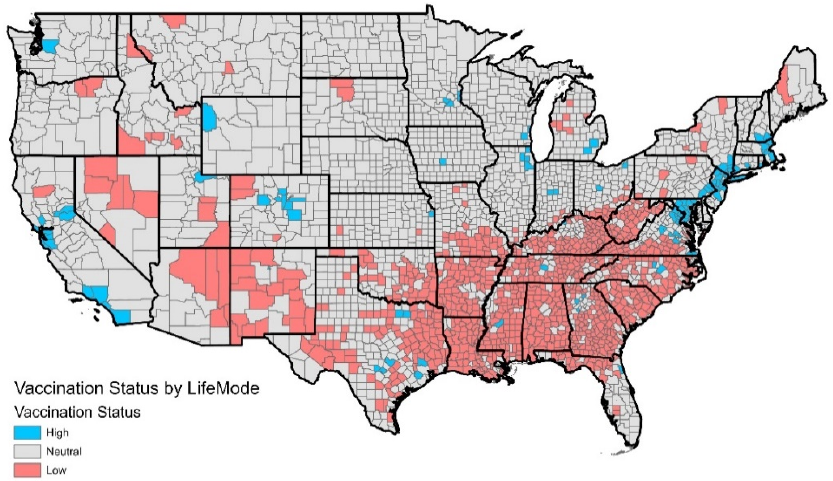
Figure 3. Vaccination status by county across the United States, estimated using the dominant LifeMode assigned to each county.